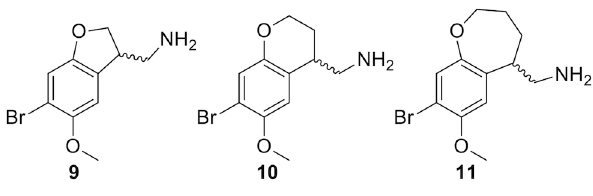
Figure 2. The new conformationally constricted analogs reported in this